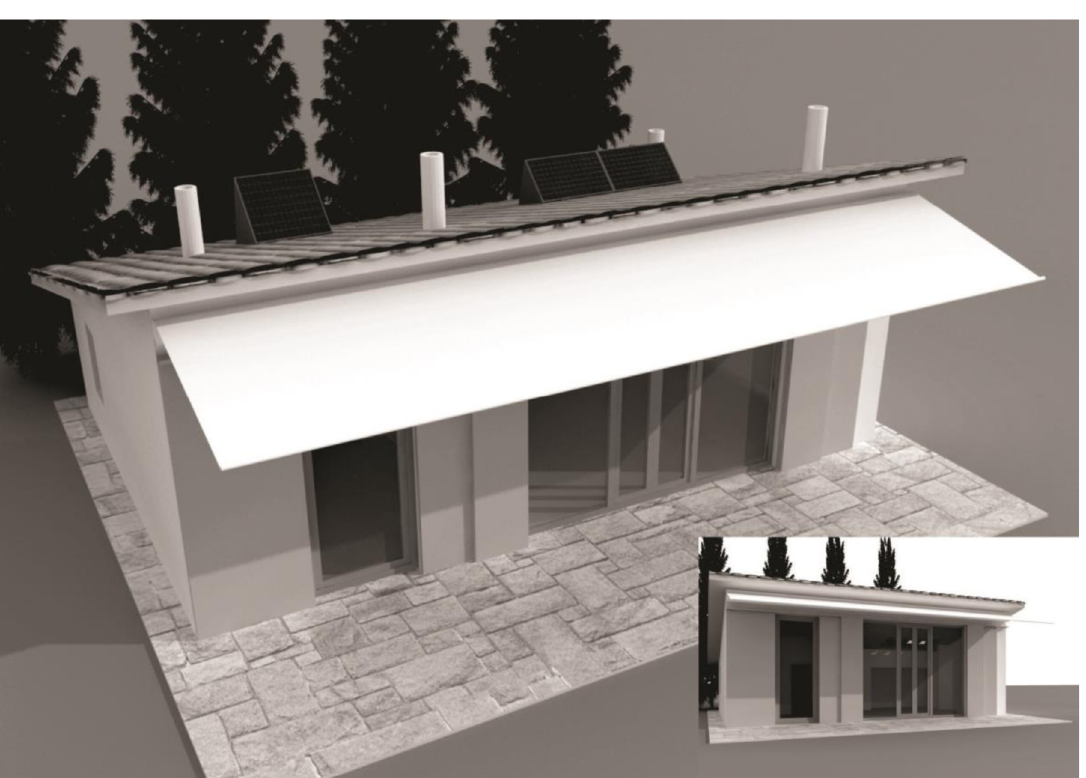
Fig. 10. Perspectives of House